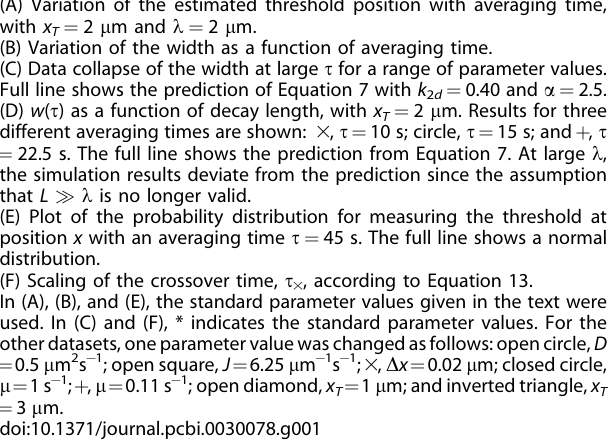
1C shows the w ; s (cid:2) 1/2 behaviour predicted in Equation 7, and Figure 1D confirms that the width has a minimum as a function of k . The simulation results are consistent with the position of the minimum predicted by Equation 9. Figure 1E shows that the distribution of measured threshold positions is Gaussian to a good approximation.